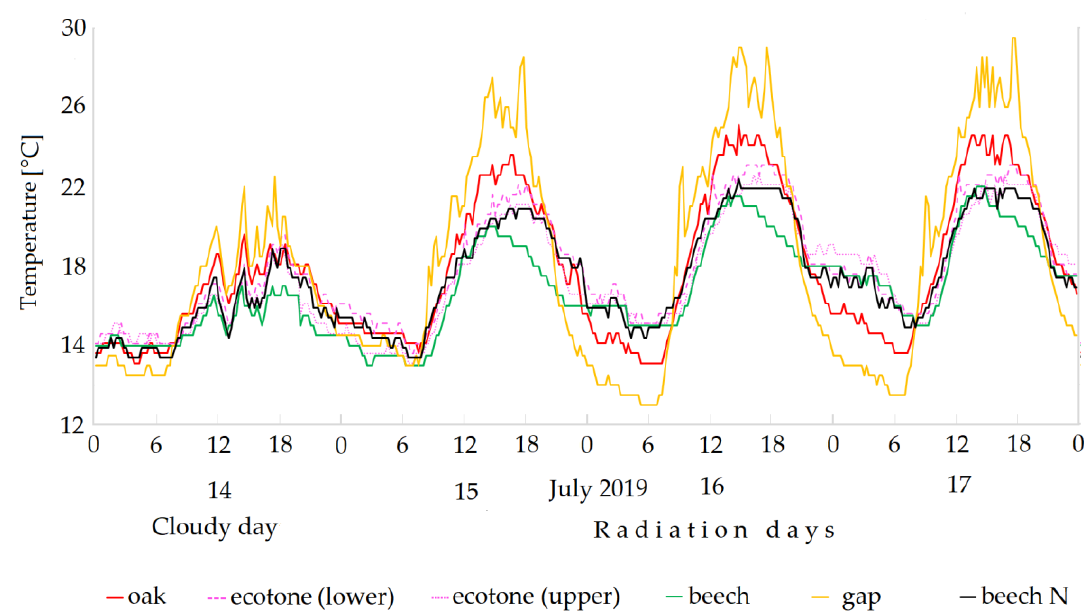
Figure 2. Diurnal course of air temperature at the six measuring points of the Milova transect on a cloudy and three cloudless days (radiation days) in July 2019.